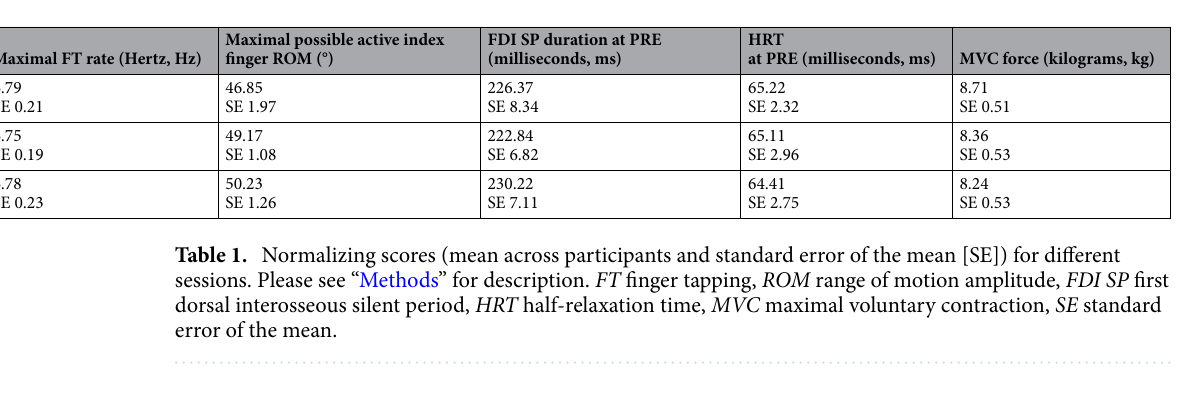
Maximal FT rate (Hertz, Hz)